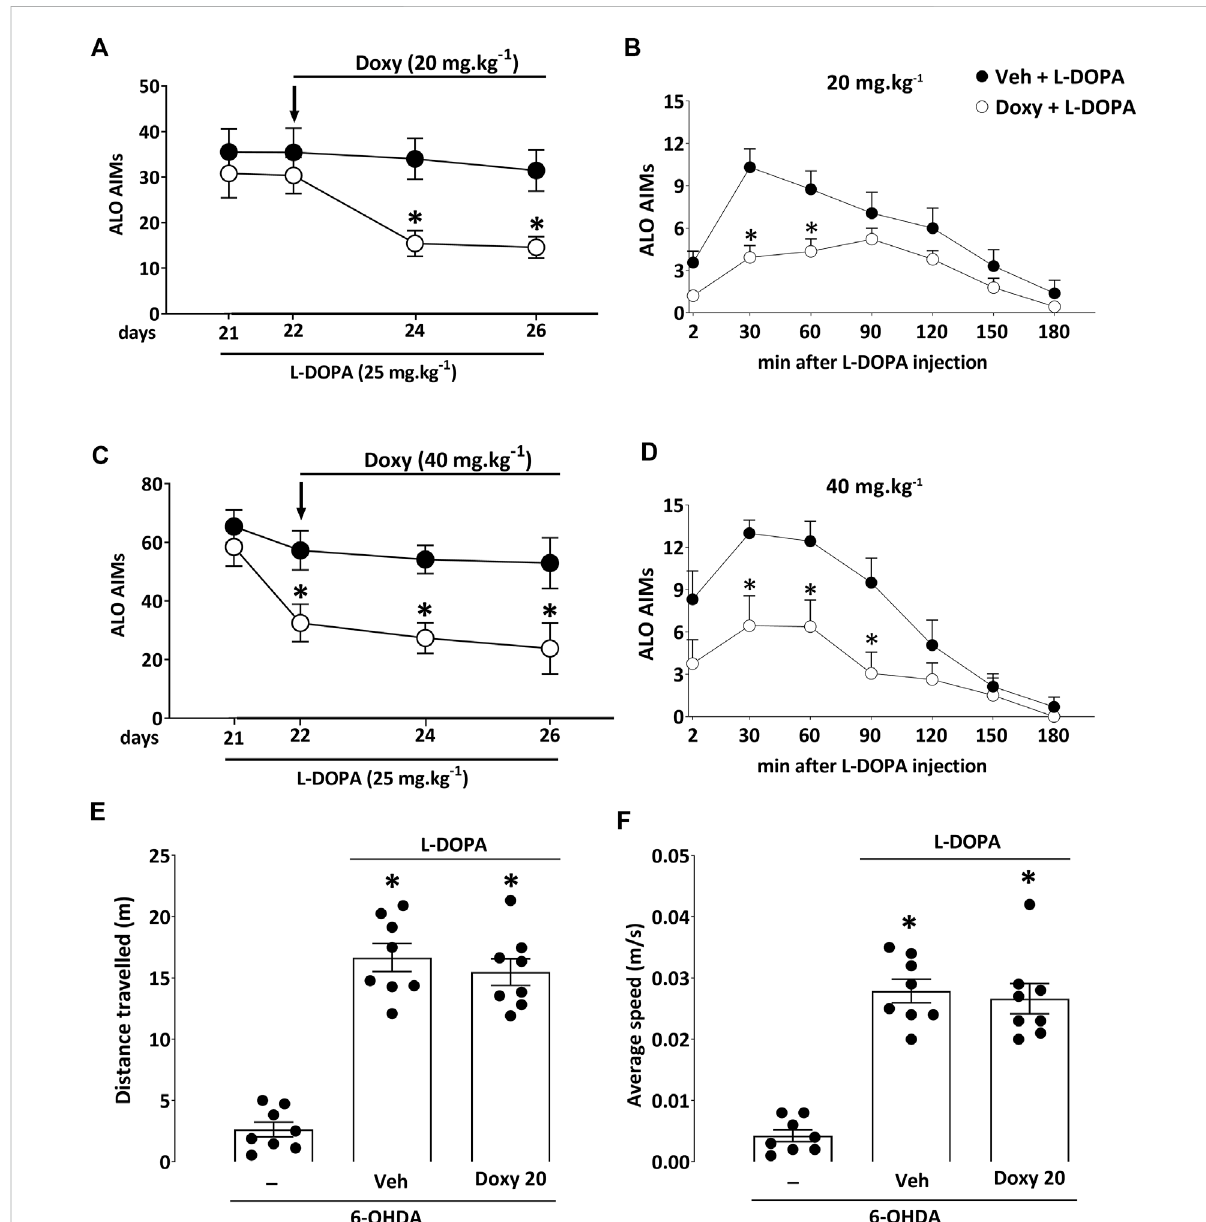
Impact of sub-chronic treatment with Doxy on established AIMs and locomotor activity in hemiparkinsonian mice with partial lesions. (A) AIMs observed in hemiparkinsonian mice with mild striatal lesions were signi fi cantly reduced at days 3 and 5 of sub-chronic treatment with Doxy (20 mg.kg − 1 s. c.). (B) At day 5 of treatment with 20 mg kg − 1 , AIMs were signi fi cantly reduced 30 and 60 min after initiating L -DOPA treatment. (C) When given at 40 mg.kg − 1 s. c. to hemiparkinsonian mice with intermediate striatal lesions, Doxy effectively reduced AIMs from day 1